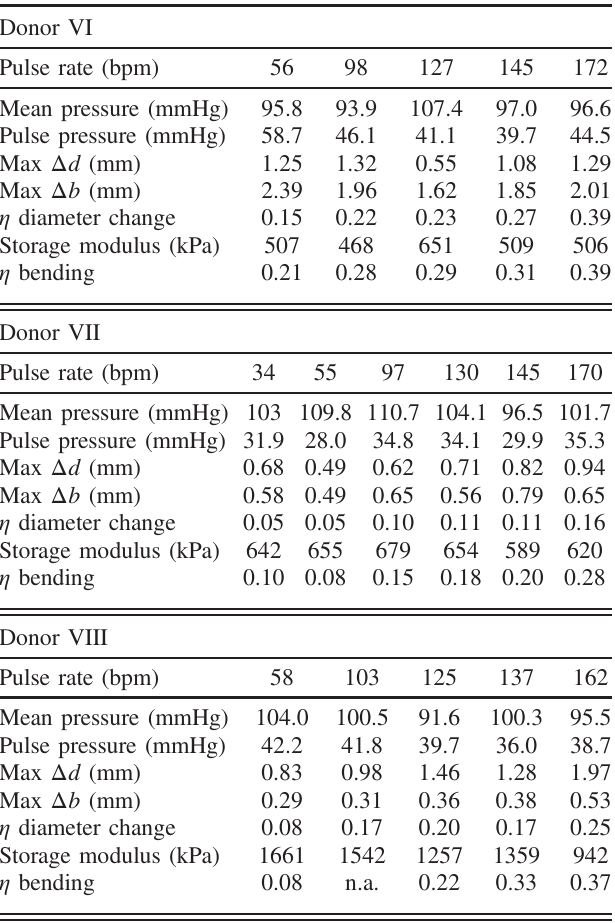
TABLE II. Experimental data of the pressure, diameter and bending displacements, loss factors, and storage moduli for the eleven aortic segments tested in the mock circulatory loop. The loss factor η associated with unsmooth and self-intersecting hysteresis loops were not reported (the corresponding value is indicated as n.a. for “ not available ”